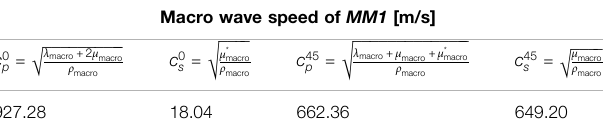
TABLE 4 | Wave speed expressions for the Cauchy material which is the long- wave limit of MM1 . The expressions for the pressure and shear waves are explicitly given for the two directions of propagation θ (cid:2) 0 and θ (cid:2) π / 4. Such speeds are the slopes of the tangents at the origin of the acoustic dispersion curves in Figures 3A,B and are computed based on the macro parameters given in the table in Figure 2A